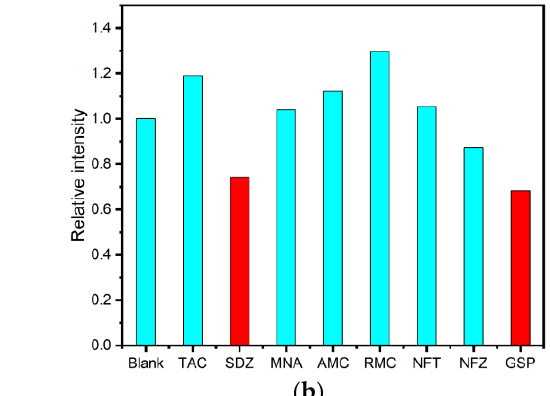
Figure 4. Luminescence intensity of MOF 1 suspension upon addition of different metal cations (C = 0.1 mM).